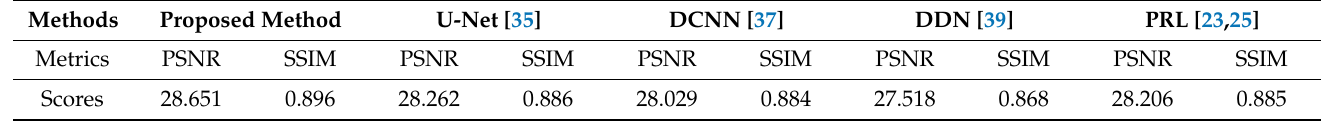
Table 3. Performance evaluation for BSDS100